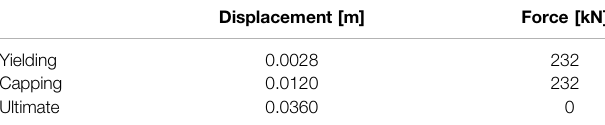
TABLE 1 | Force-displacement backbone